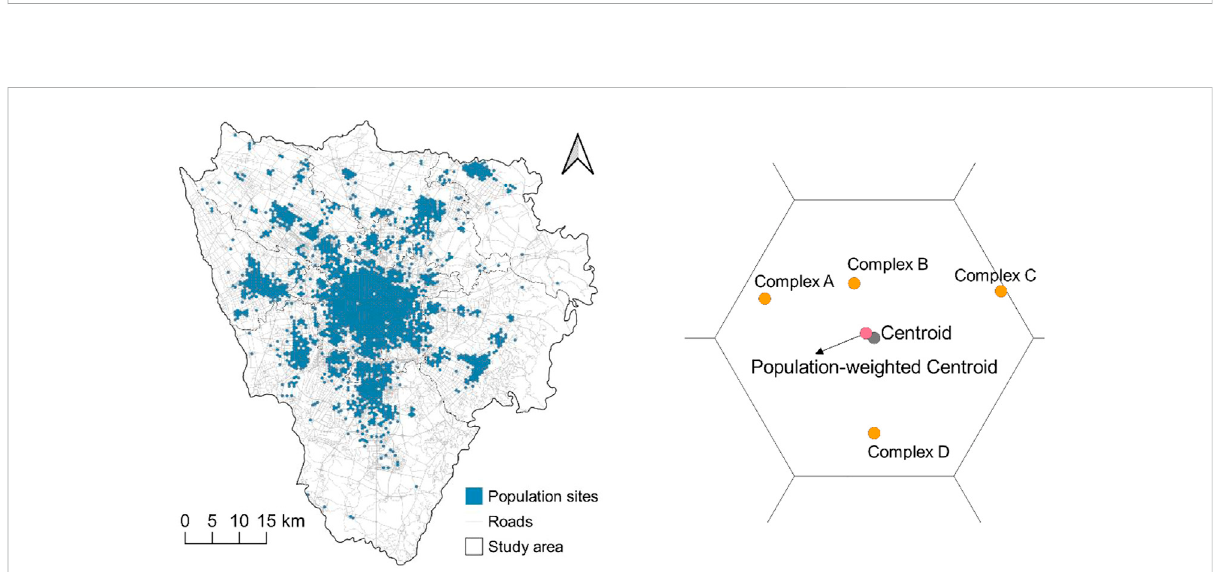
FIGURE 3 Geographic distribution of those population hexagons in